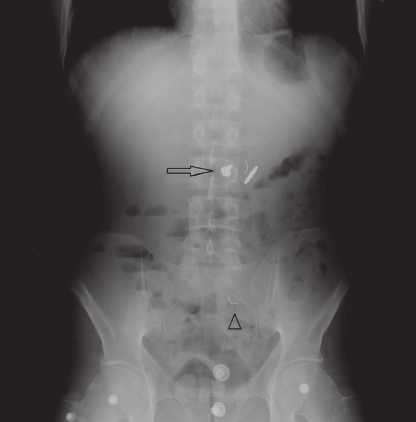
Figure 1: Abdominal X-ray: arrow showing 3 metallic objects (screw, coin, and plastic head pin) in the stomach, and arrow head showing another plastic head pin well into the small intestine. Note that the small metal scrap that was later seen on endoscopy is not evident